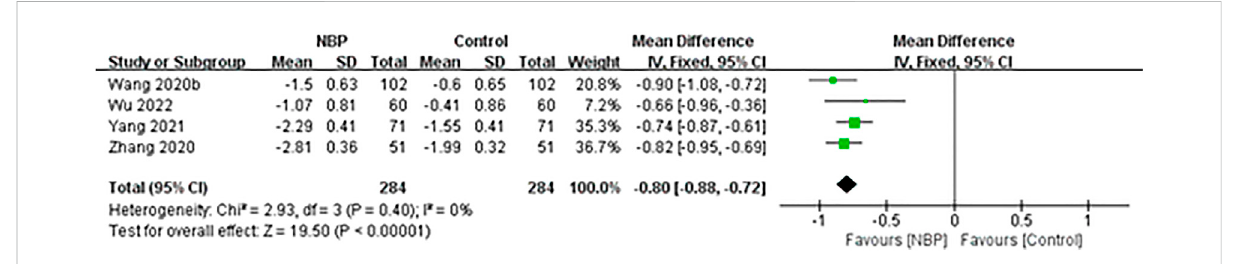
FIGURE 4 Meta-analysis of death during the treatment period or follow-up.